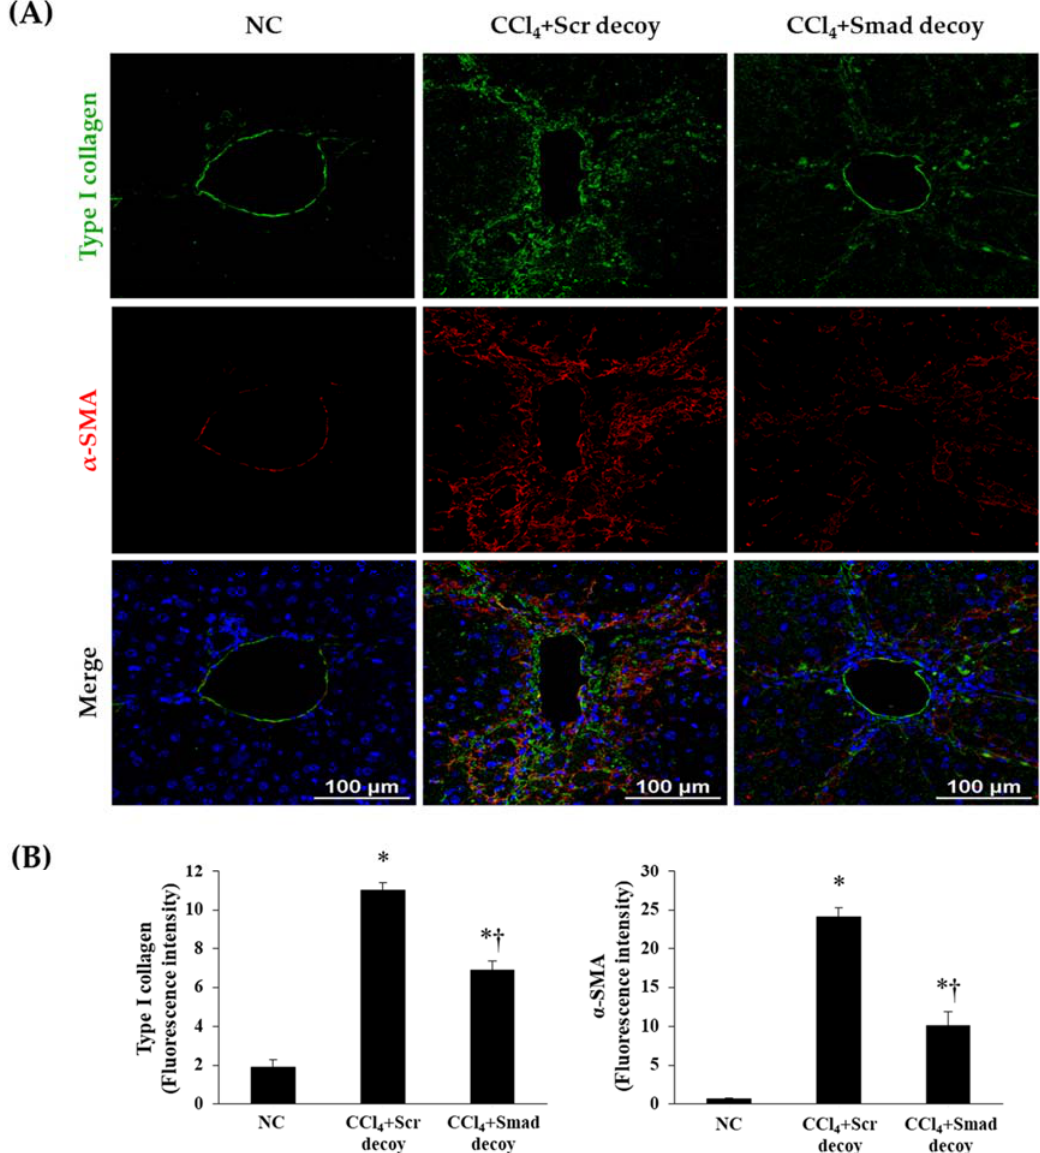
Figure 3. Expression of extracellular matrix (ECM) decreased by Smad decoy ODN in CCl 4 -induced hepatic fibrosis in mice. ( A ) Immunofluorescence double staining for type I collagen (green) and α -SMA (red) showed that Smad decoy ODN administration suppressed ECM deposition around of portal vein. The nuclei were stained with Hoechst. ( B ) Quantification of type I collagen and α -SMA fluorescence intensity. Scale bar = 100 µ m. * p < 0.05 compared to normal control group; † p < 0.05 compared to the CCl 4 +Scr group.